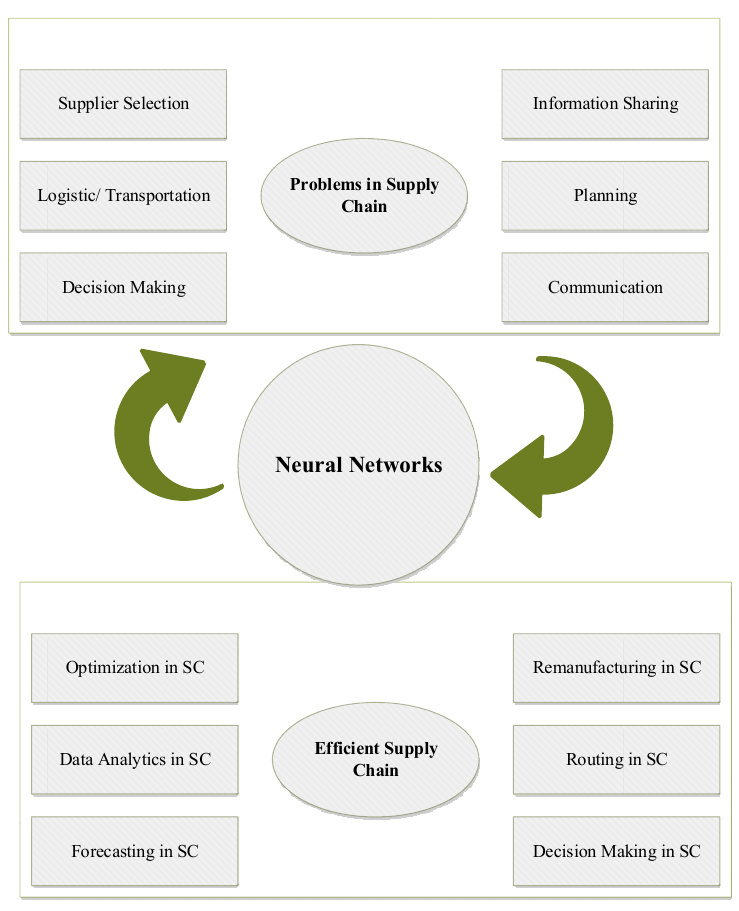
Figure 10. A suggested research framework for NNs in SCM.